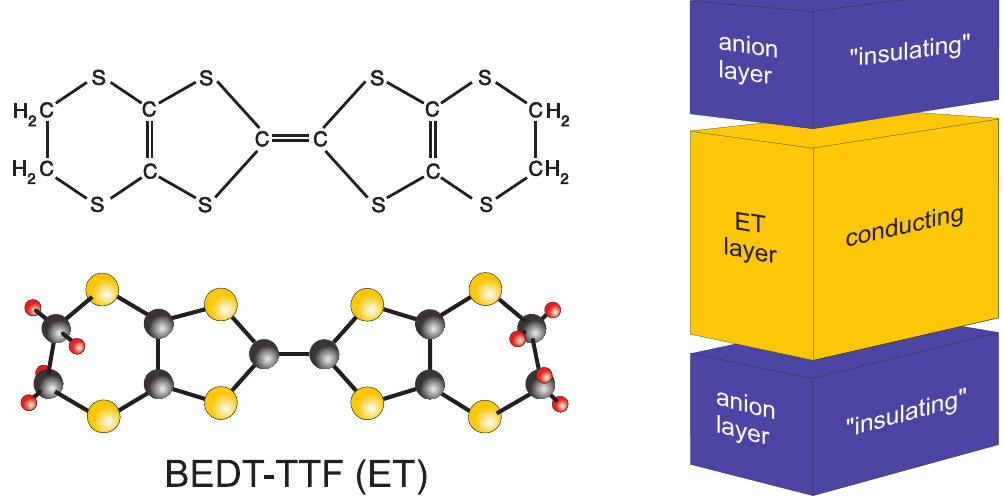
Figure 1. (left) The molecular structure of bis (ethylenedithio)tetrathiafulvalene (BEDT-TTF or ET); (right) Schematic arrangement of the ET and anion layers in the quasi-two-dimensional organic